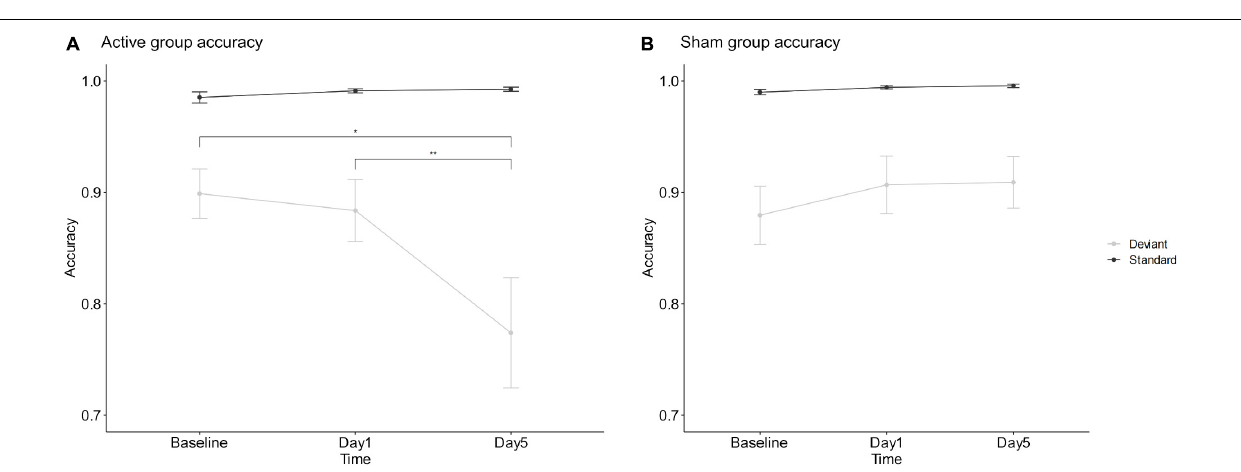
(19), ADHD individuals (35), and gambling addicts (18),